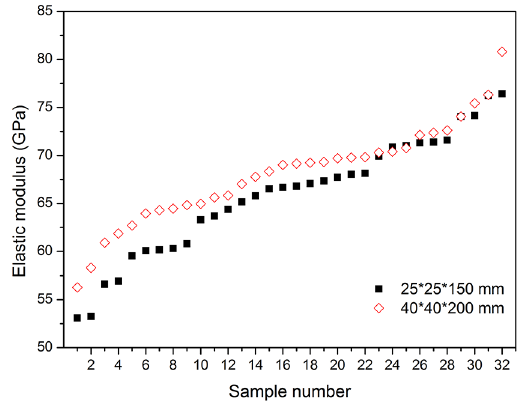
Figure 6. Distribution of elastic modulus of high alumina bricks a small standard deviation, which was consistent with the lower limit of the sample number given by the literature 32 .